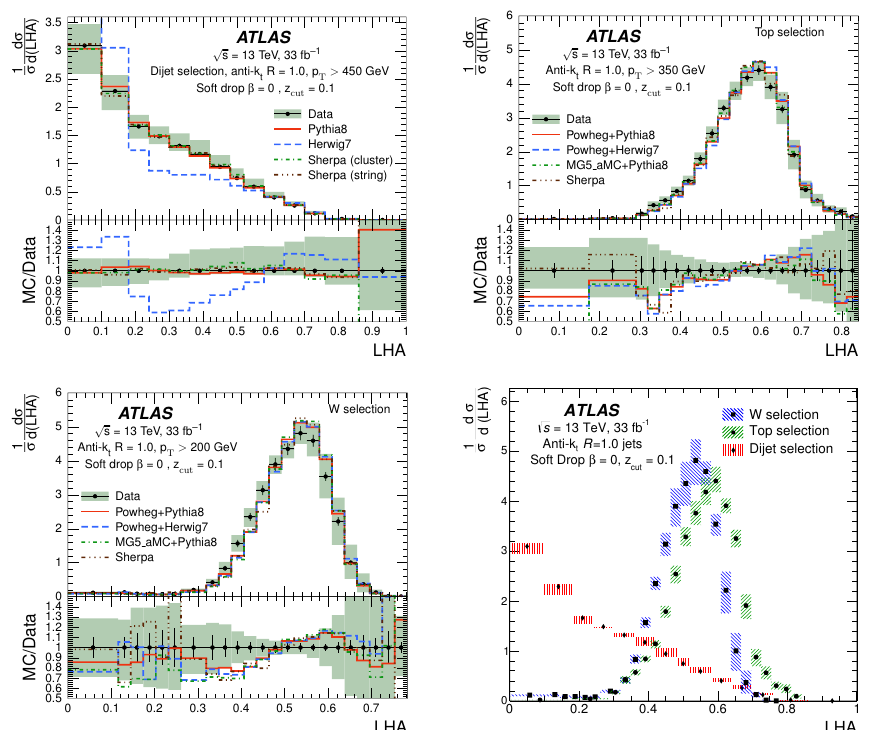
Figure 4 . Les Houches angularity is compared with different MC predictions for soft-dropped large-radius jets from dijet (top left), top (top right), and W (bottom left) selections. For the dijet selection, Sherpa is tested with two different hadronisation models. Data are compared between the soft-dropped large-radius jets for the three selections mentioned above (bottom right). The shaded bands represent the total uncertainty, while the error bars show the statistical uncertainty, except in the bottom right plot, where the shaded areas represent the total